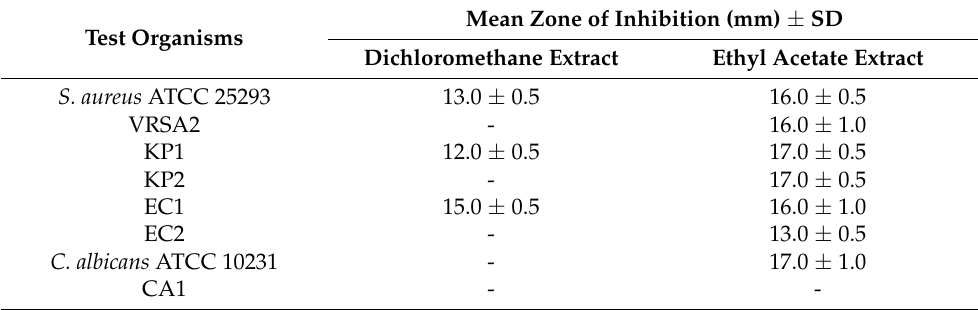
Table 3. The antimicrobial activity of the of the solvent extracts of A. faecalis isolate